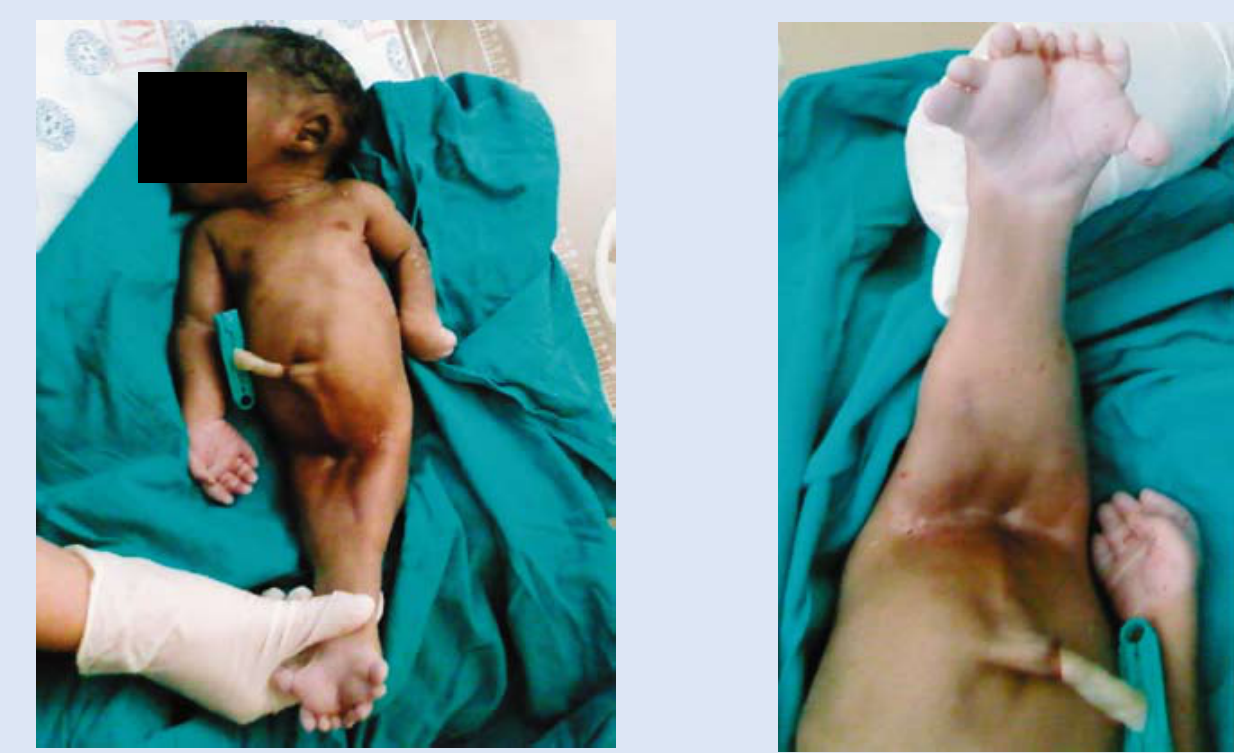
Fig. 1. Photo’s of a siren with fused lower